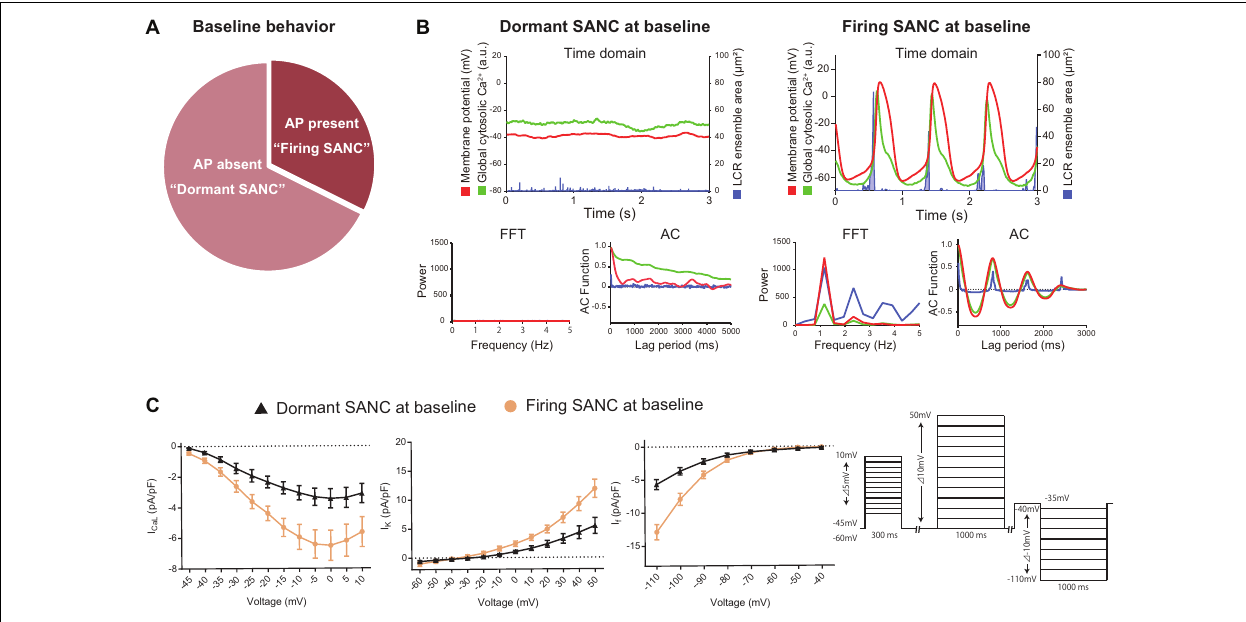
FIGURE 1 | (A) The proportion of baseline behavior of freshly isolated guinea pig SANC we studied total 34 cells. About 1/3 and 2/3 were AP present (firing) and AP absent (dormant), respectively. (B) Illustrative examples of simultaneous voltage (magenta), global cytosolic Ca 2 + (green) and LCR ensemble area (blue) in dormant SANC (left) and firing SANC (right) at baseline. The corresponding frequency analysis by fast Fourier transform (FFT) and autocorrelation analysis (AC) are shown below. (C) Major ion current density of voltage-dependent L-type Ca 2 + channel, voltage-dependent K channel and the funny current in dormant (black) and firing (yellow) SANC at baseline; those of dormant SANC were reduced compared to those of firing SANC. The protocol is shown in the right panel.